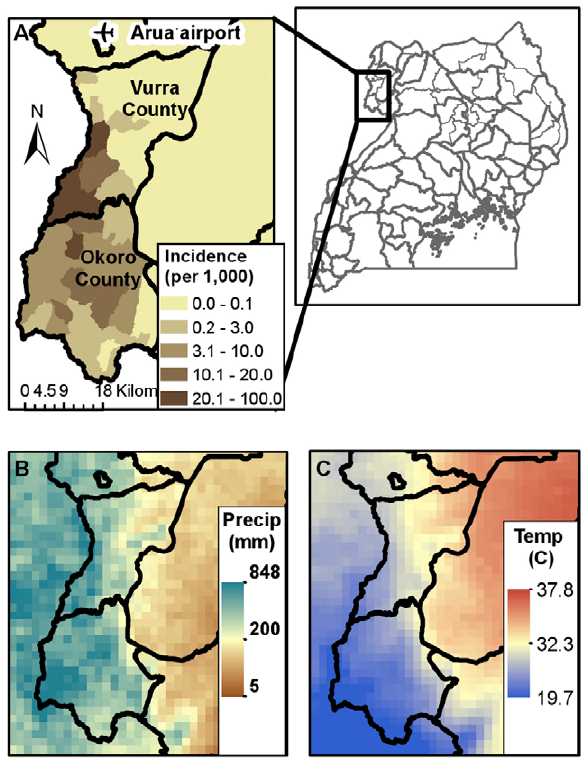
Figure 1. Spatial distributions of plague, temperature, and rainfall in West Nile region of Uganda. (A) Reported cumulative plague incidence per 1,000 population from 1999–2007 in Vurra and Okoro counties of Uganda. (B) Average August rainfall (mm) and (C) average February maximum temperatures ( u C) in northwestern Uganda. Temperature and rainfall averages were based on data from 1999–2009 generated using a 2 km Weather Research Forecasting (WRF) model